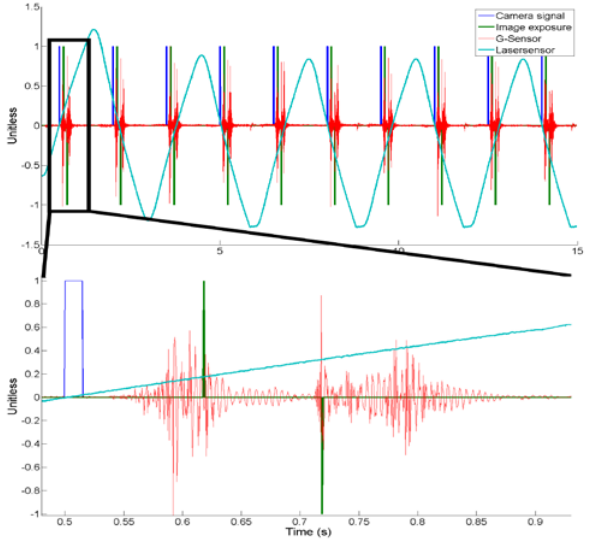
Figure 6. Measurements and camera release during shaking